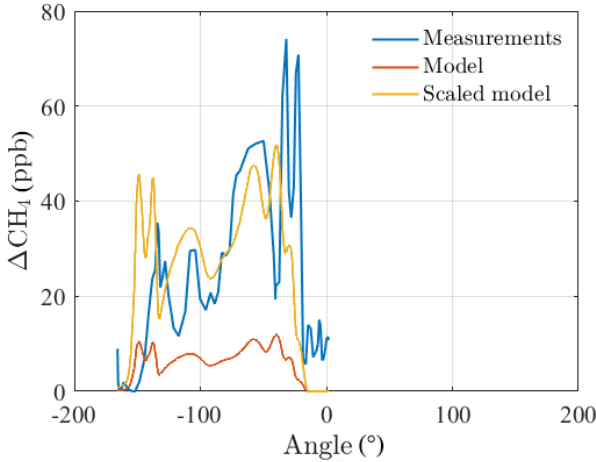
Figure 6. Measurement curve (blue) with the a priori forward model (orange) and the scaled forward model